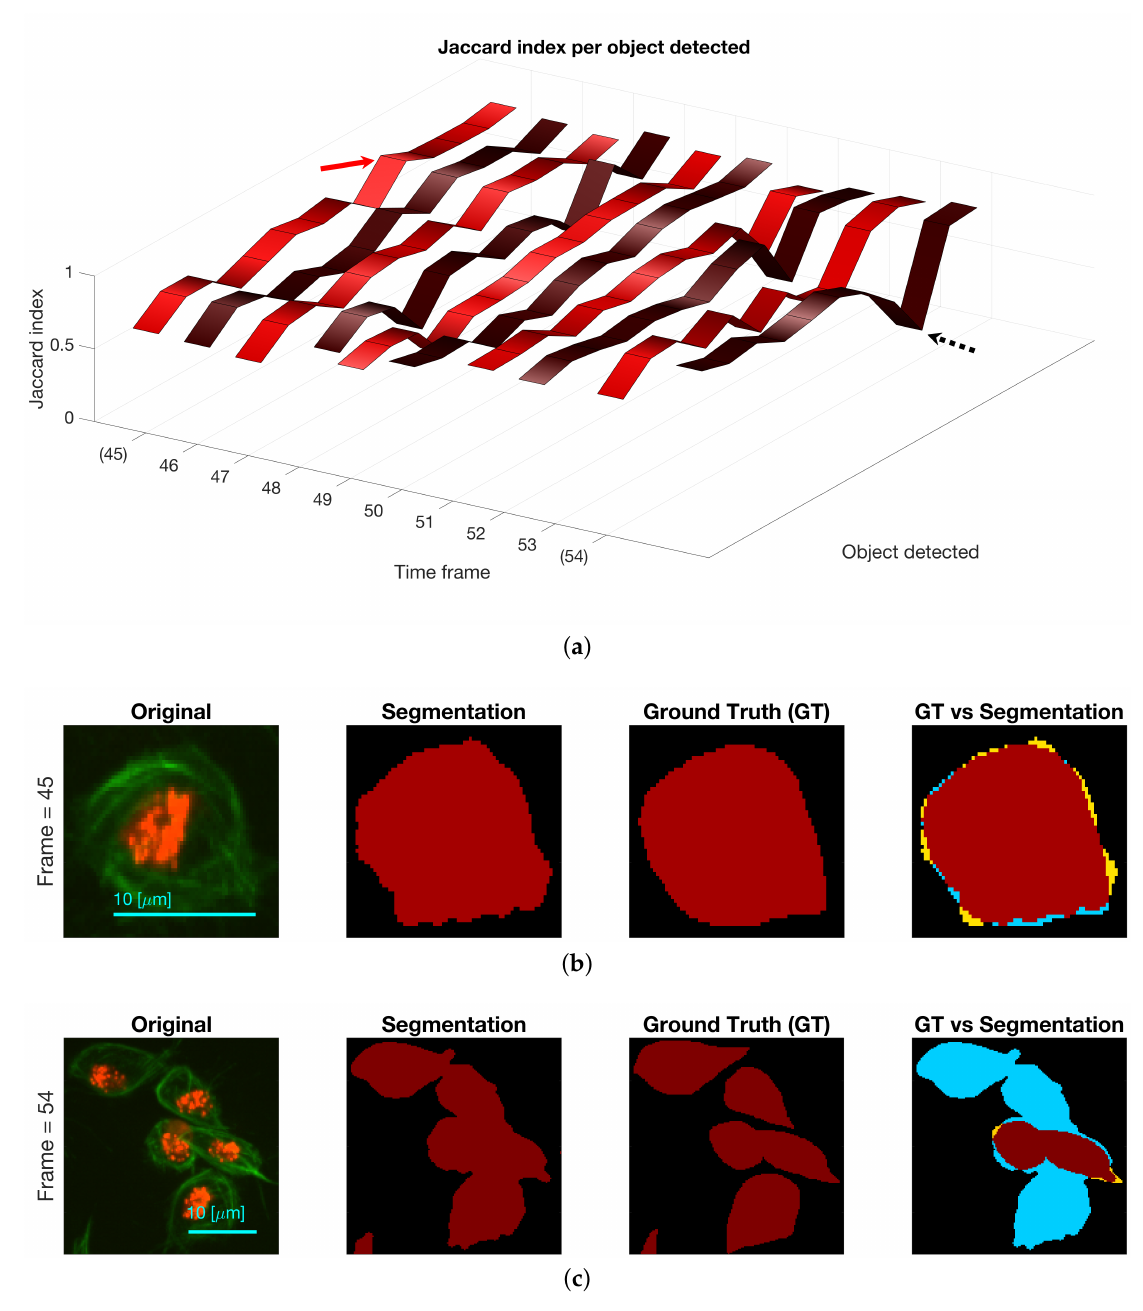
Figure 13. ( a ) Comparison of the Jaccard index for each object detected, whether it is a clump or not, at each of the ten frames with available ground truth. Two frames are highlighted (45 and 54) and arrows point at values in the ribbon. ( b ) Depiction of cell in frame 45 that achieved a high Jaccard index in Top row (red arrow). ( c ) Depiction of clump detected in frame 54, and its comparison with the ground truth. The black dotted arrow in the top row show the Jaccard index value of the clump shown. Regarding the colours in the segmentation comparison: black is the background, yellow represent the false negatives, blue the false positives and red the true